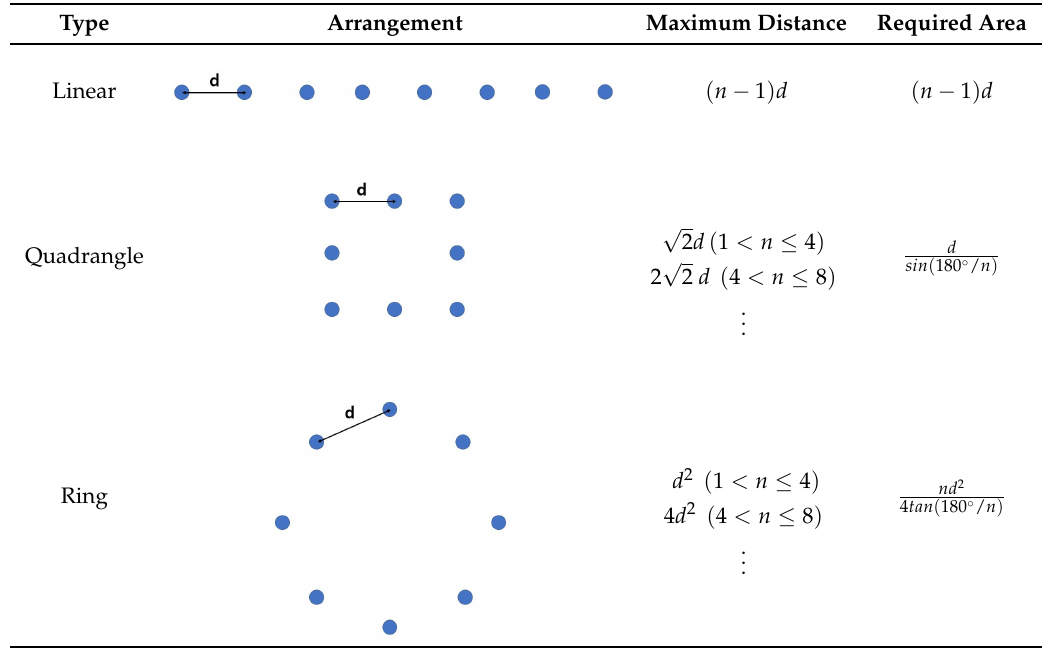
Table 1. Comparison of the arrangement of